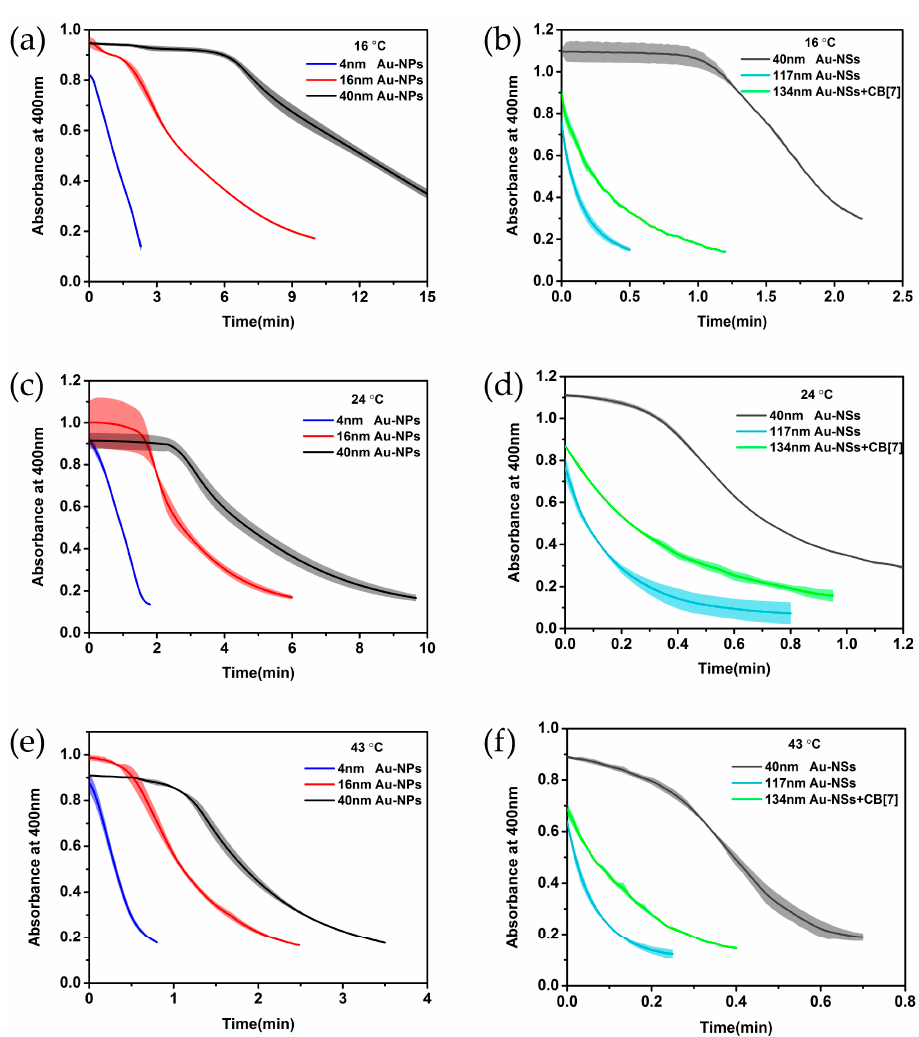
Figure 2. The peak intensity at 400 nm for 4 ‐ NPas a function of time at three different temperatures in the presence of: ( a ) Au ‐ NPs at 16 °C; ( b ) Au ‐ NSs at 16 °C; ( c ) Au ‐ NPs at 24 °C; ( d ) Au ‐ NSs at 24 °C, ( e ) Au ‐ NPs at 43 °C, and ( f ) Au ‐ NSs at 43 °C. In all cases, the concentrations of 4 ‐ NP and NaBH 4 were 7 × 10 − 5 and 2.1 × 10 − 2 M, respectively, and the concentration of Au ‐ based catalyst was ~8.89 mg/L of Au atoms. The error bars represent standard deviations obtained from three or more trials. The absorption s pectra were acquired with a UV ‐ 3600 UV ‐ vis ‐ NIR (ultraviolet–visible–near infrared) spectrometer (Shimadzu, Kyoto, Japan).